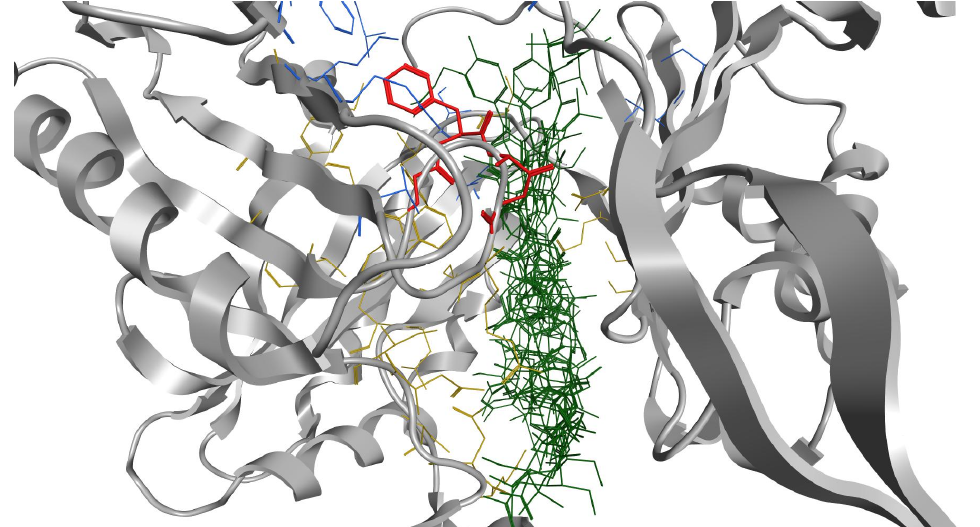
Figure 8. All 15 poses obtained for novobiocin (green) are located in the distal pocket (yellow). The proximal pocket is shown in blue and the loop in red.